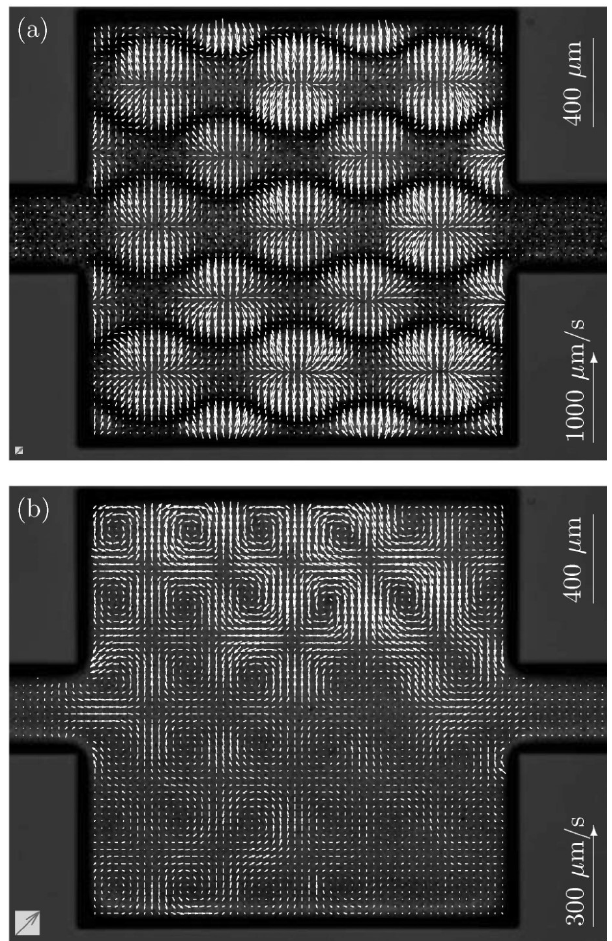
Figure 6. Microstreaming and radiation forces observed at 2.17 MHz acoustic resonance using ( a ) 5- µ m beads and ( b ) 1- µ m beads. Reproduced with permission from [39].